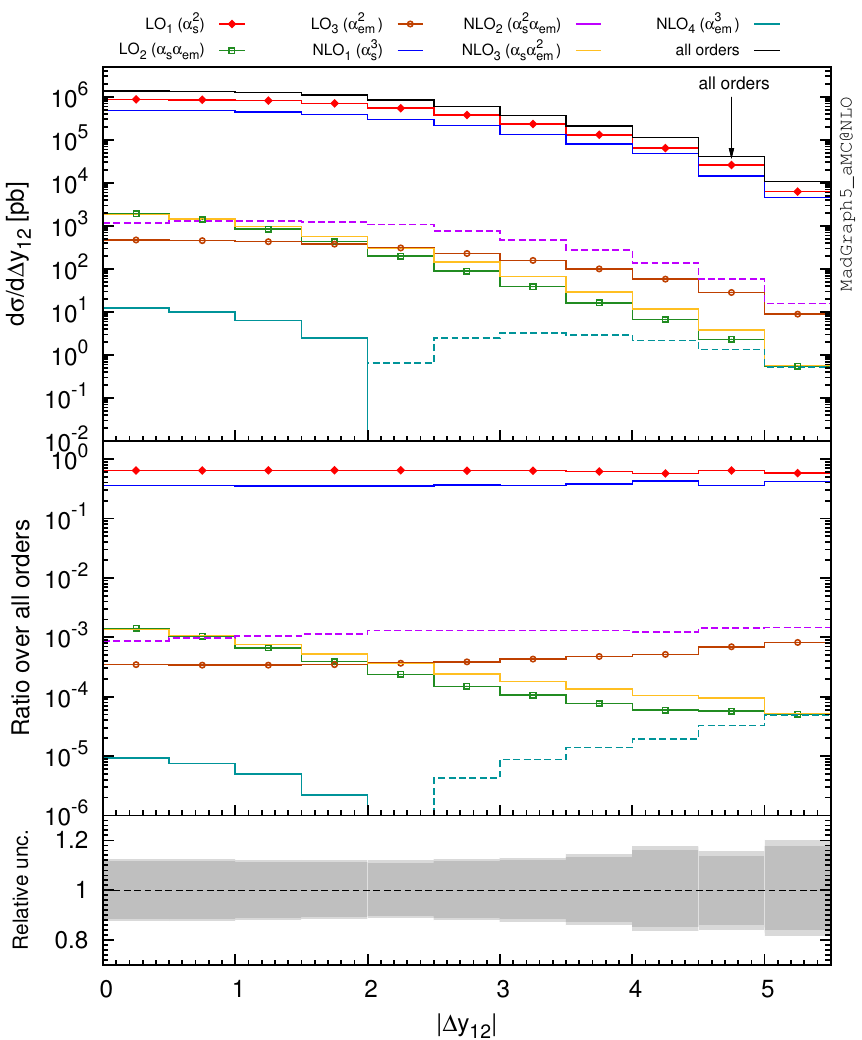
Figure 13 . Rapidity distance between the two hardest jets.